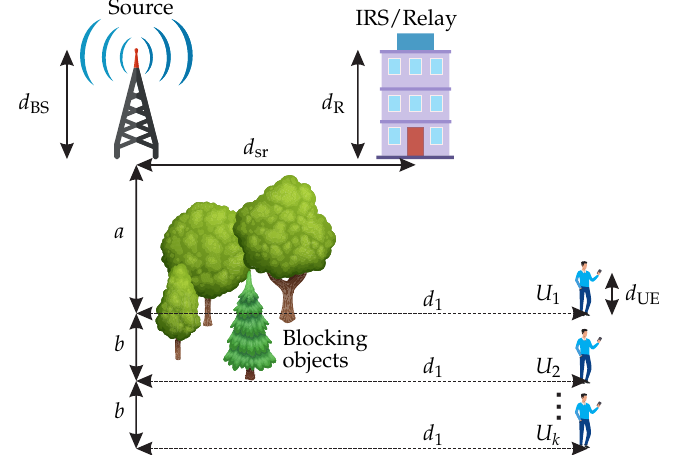
Figure 5. The simulation scenario where d 1 is varied with the same value for all users, while a = 10 m is the closest user distance from the source and b = 1m are the distances among users.